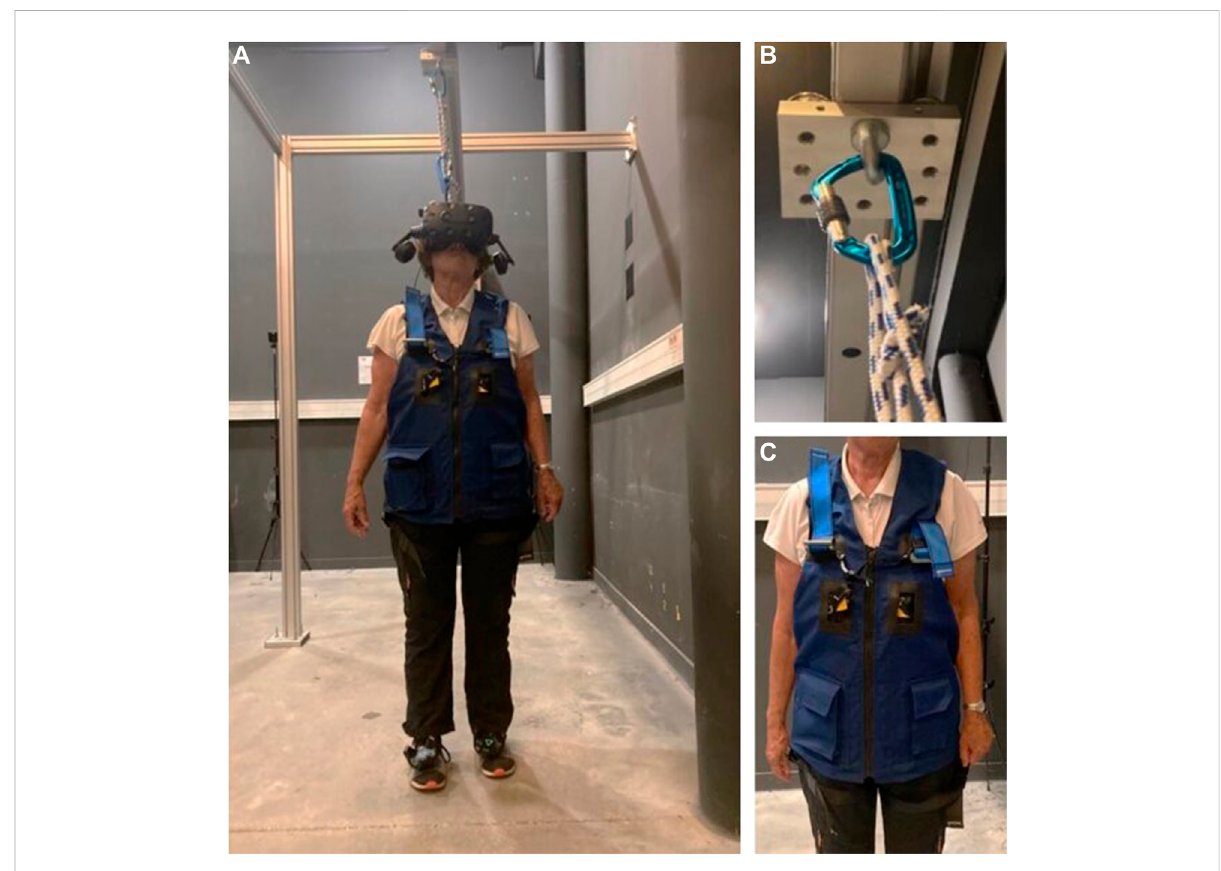
FIGURE 1 Illustrations of the test equipment. (A) Older adult performing the task. A wireless HTC Vive Pro ® was used to display the VR environment. Two HTC Vive Pro ® 2.0 trackers (placed on the feet) were used to record the positions of the feet and display virtual 3D shoes in the VR. The security system is composed of (C) a safety harness connected to (B) an in-ceiling rail by a lanyard.